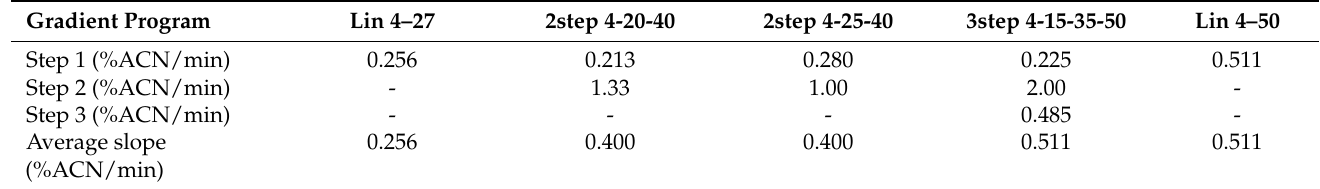
Table 2. The steepness of the gradients between the various steps and the average slope for the whole elution window. ACN: